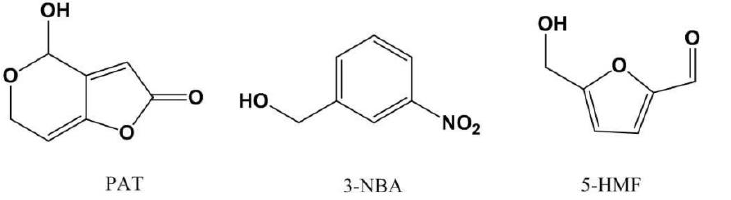
Figure 1. Chemical structure of patulin (PAT), 3-nitrobenzyl alcohol (3-NBA), and 5-hydroxymethylfurfural (5-HMF).